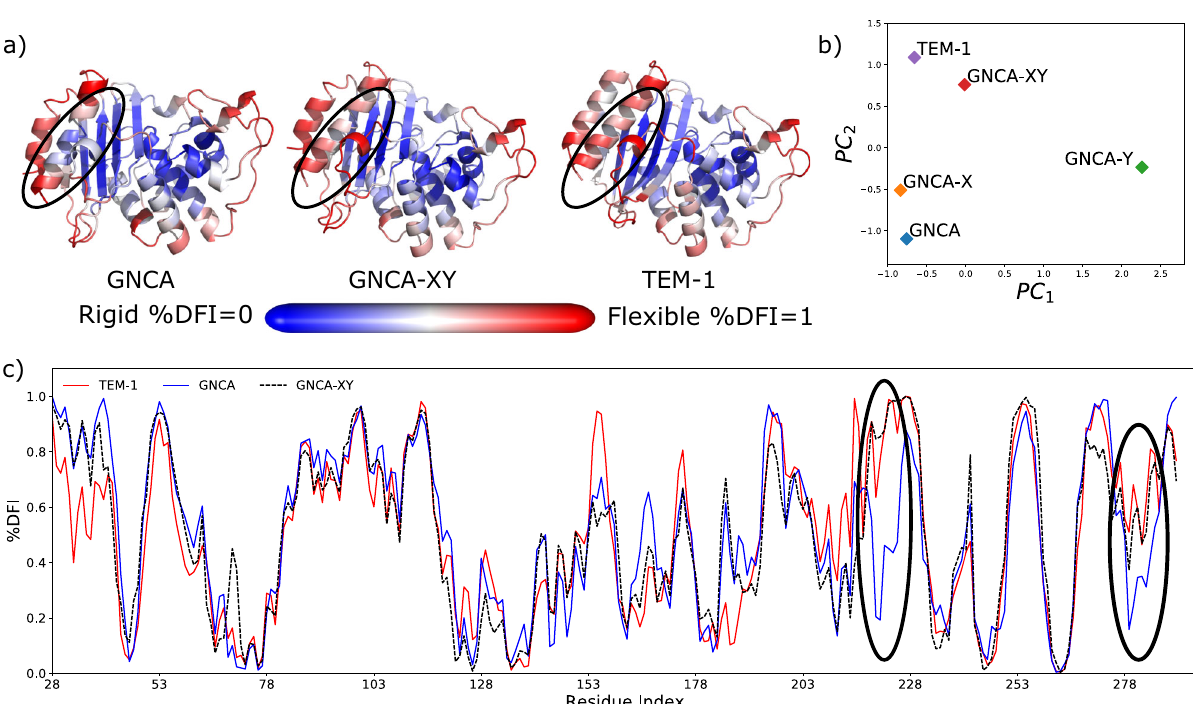
Fig. 3 The similarities in the fl exibility pro fi les of GNCA-XY mutants compared to the wild-type GNCA and TEM-1 β -lactamase. a Color-coded DFI pro fi les mapped onto the 3D structure where red is fl exible and blue is rigid, b clustering of these pro fi les using principal component analysis (PCA), c the plot of mapped DFI pro fi les per residue position for each protein. The PCA analysis shows that GNCA-XY is similar to TEM-1 β -lactamase as shown in the principal component biplot. GNCA-XY mimics the fl exibility pro fi le of TEM-1 β -lactamase more closely than mutation sets X and Y alone, particularly around residues 220 and 280 (highlighted) in panel ( c ), also seen in their cartoon representations color-coded with the fl exibility pro fi le of their residues, red being fl exible and blue rigid. The computed data are provided as a Source Data fi